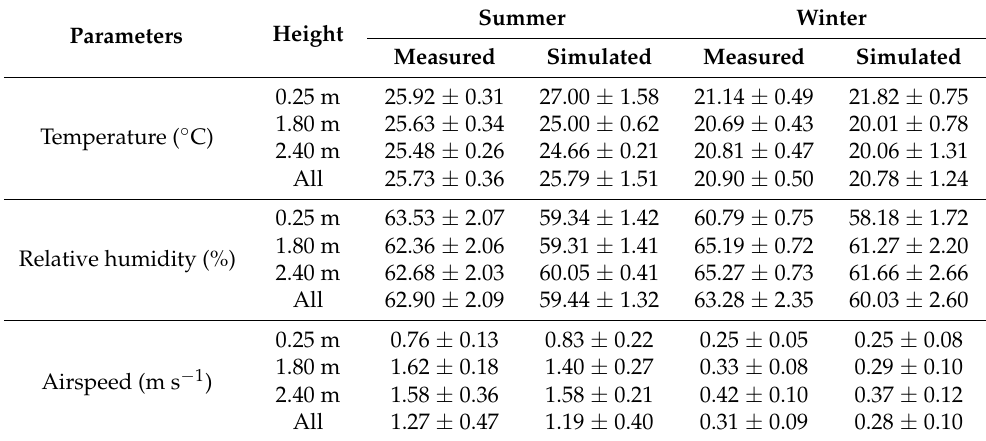
Table 3. Measured and simulated temperature, relative humidity, and airspeed values (mean ± stan- dard